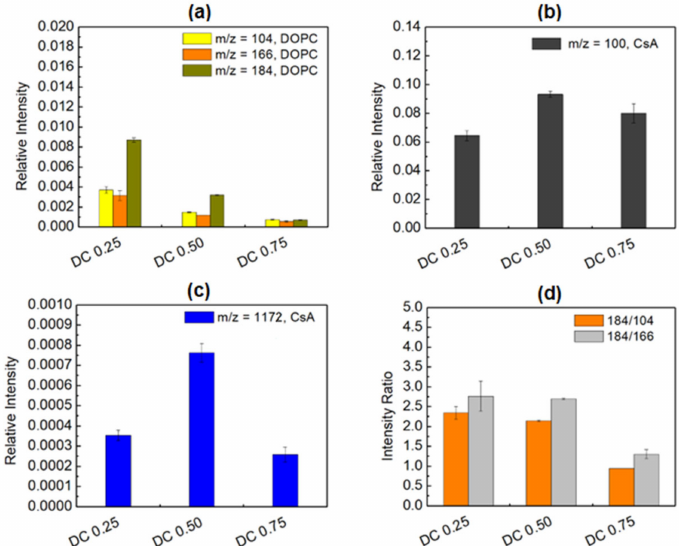
Figure 6. Distribution of 1,2-dioleoyl- sn -glycero-3-phosphocholine m / z = 104, 166, and 184 (phospho- choline) fragments ( a ), cyclosporine (C 6 H 14 N) + fragment ( b ), cyclosporine m / z = 1172 fragment ( c ), intensity ratio of DOPC to DOPC fragments ( d ) in the binary DOPC-CsA monolayers with different molar fractions of CsA deposited onto PET air